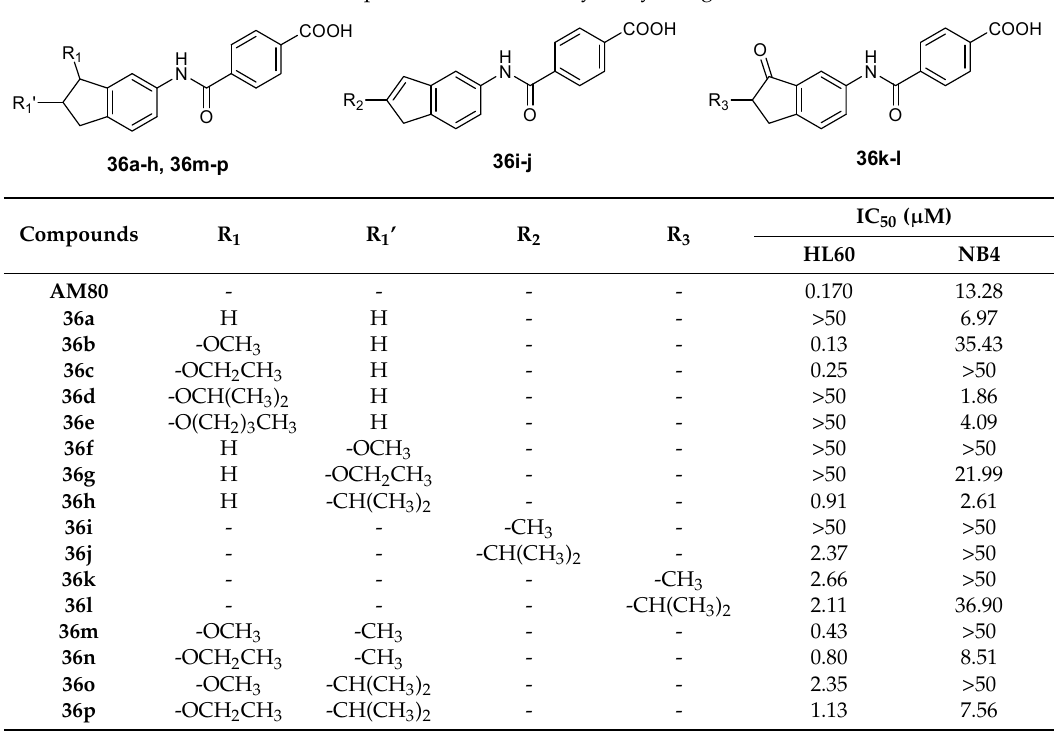
Table 2. Results of cell proliferation inhibitory assay using HL60 and NB4 cells. Table 1. RAR α binding affinity of compounds 36a – 36p